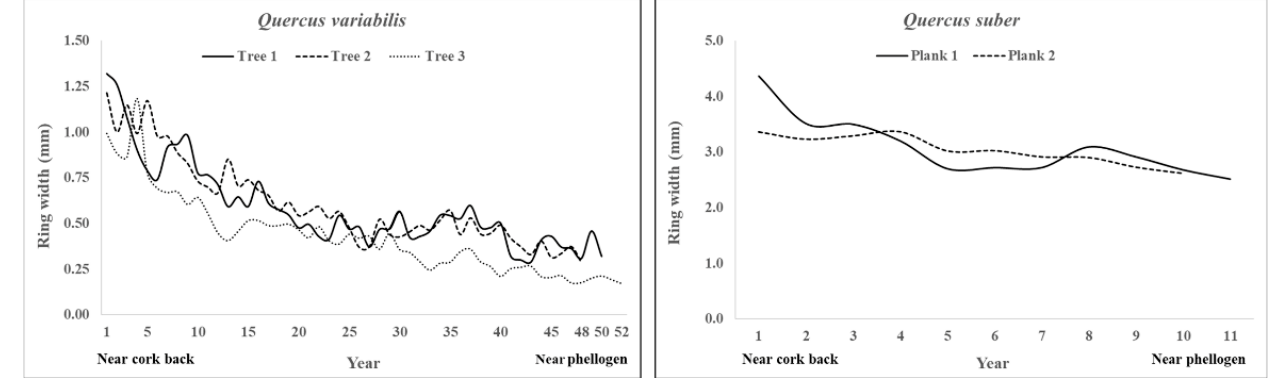
Figure 3. Variation in growth ring width from the cork back to the phellogen in Q. variabilis virgin cork and Q. suber reproduction cork.